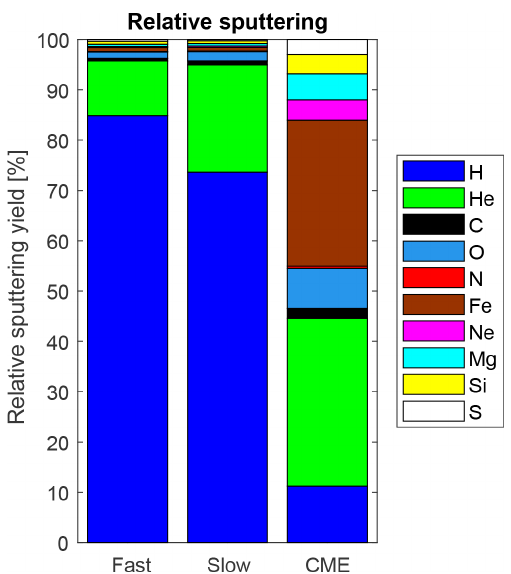
Figure 3. Weighed relative sputtering yield of carbon for the three different solar wind compositions; results for astronomical silicate and Fe 0 . 4 Mg 0 . 6 O are similar, but the absolute values vary according to Fig.